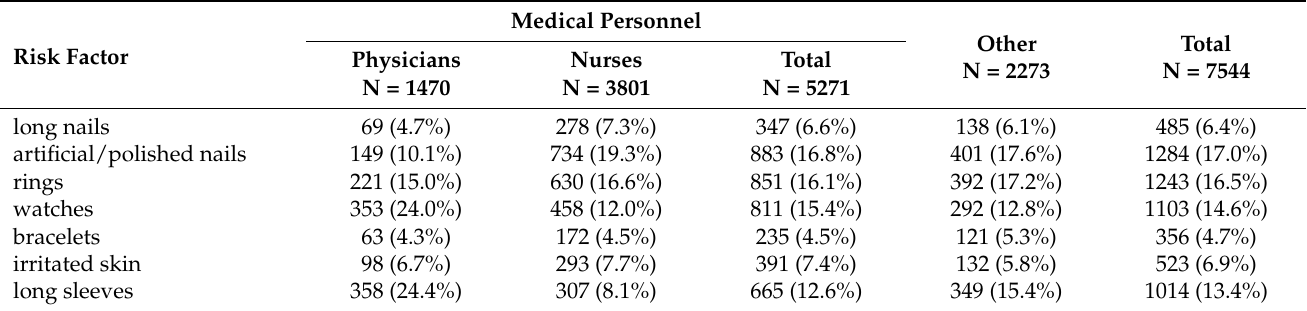
Table 4. Analysis of risk factors among participants who improperly prepare hands for disinfection according to the participant profession.